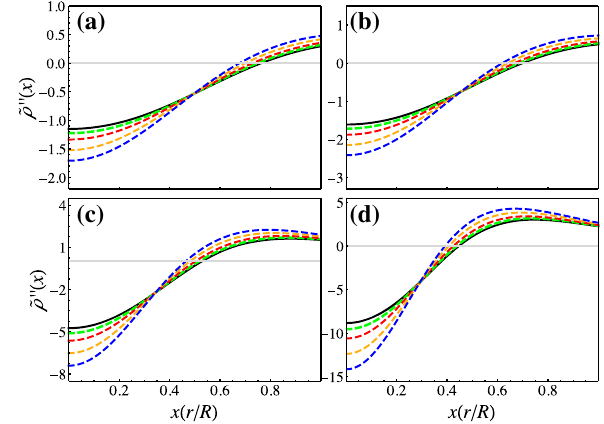
Fig. 8 Traverse sound velocity, v 2 t , a u = 0 . 13, b u = 0 . 15478, c u = 0 . 2035, d u = 0 . 229365. α = 0 (black solid line), α = 0 . 04, (green dashed line), α = 0 . 1 (red dashed line), α = 0 . 2 (yellow dashed line), α = 0 . 3 (blue dashed line) ( d )